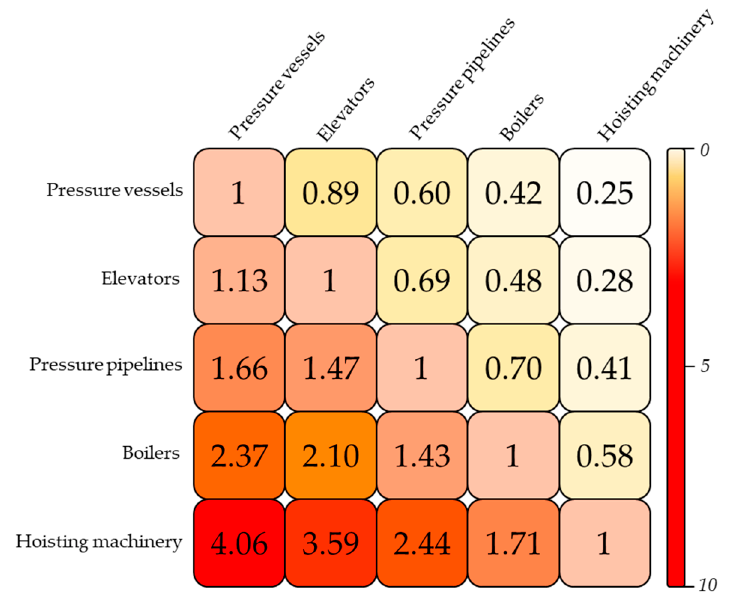
Figure 2. Relative risk matrix of multiple types of hazardous industrial installations in China in the period of 2006 to 2010 271